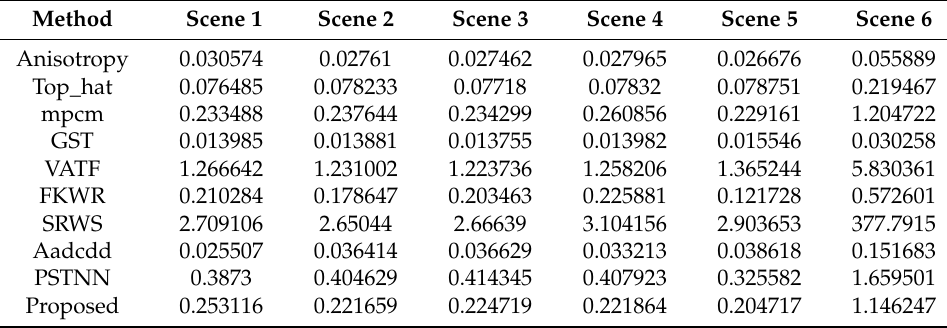
Table 4. Average single frame run time for all methods. (Unit: